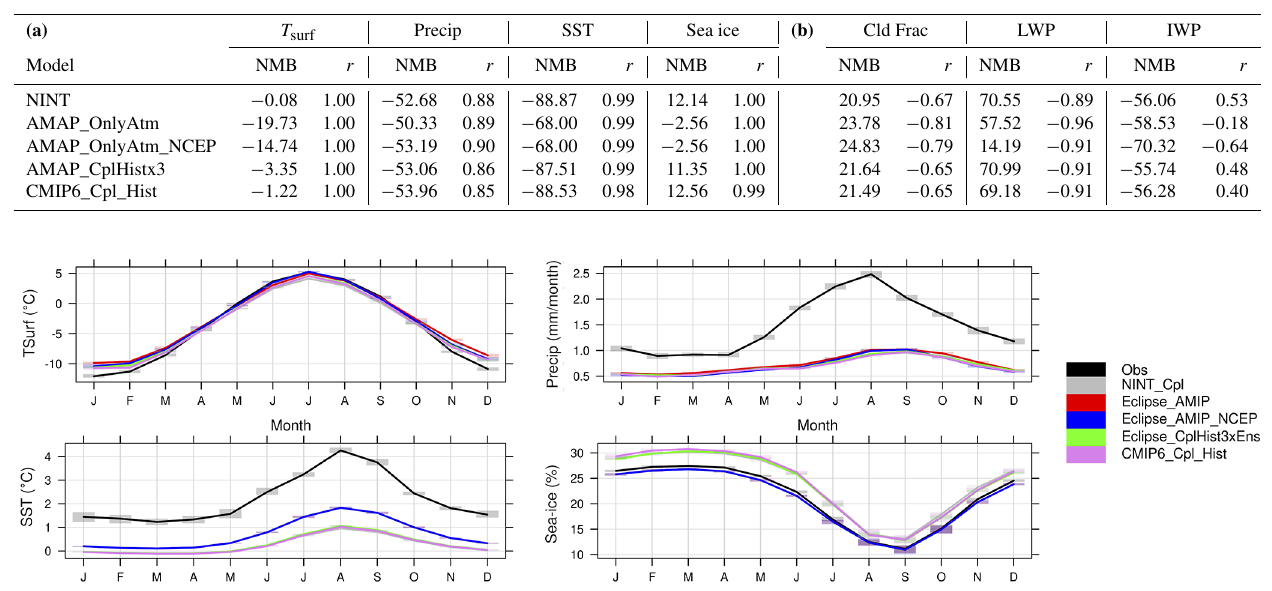
Figure 4. Observed and simulated Arctic climatological (1995–2014) surface air temperature, precipitation, sea surface temperature, and sea ice, along with the interannual variation shown in bars. Obs denotes the UDel dataset for surface air temperature and precipitation, and HadISST denotes that for sea surface temperature and sea-ice extent. Note that the two AMIP runs (blue and red lines) for the SST and sea ice are on top of each other as they use that data to run as